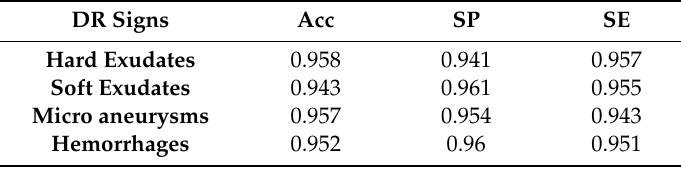
Table 5. Performance of Proposed method over Diaredb1 database.